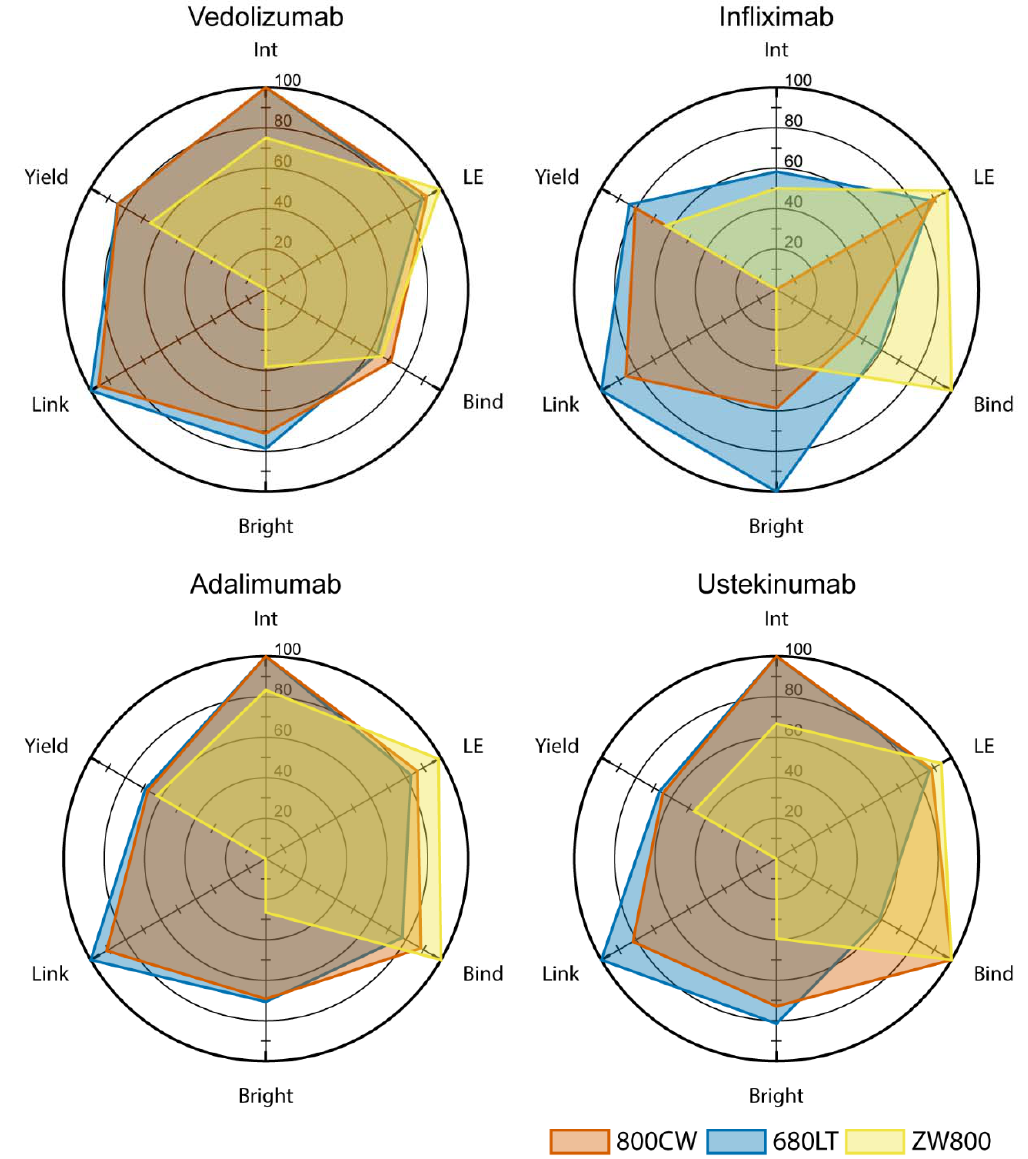
Figure 7. Feasibility assessment radar graphs. A score is calculated in 6 critical parameters for each tracer candidate. Each parameter is scored on a 0–100 scale and plotted on the radar graph for performance comparison within and between antibodies. All six parameter scores were added up for a total feasibility score (Table 1) to determine the most feasible antibody-dye combination. Int: Antibody Integrity; LE: label efficiency; Bind: Target binding affinity; Bright: Fluorescent brightness; Link: Link stability.